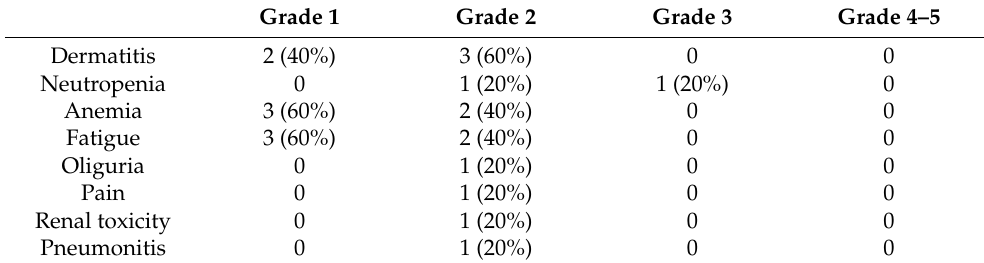
Table 2. Side effects for TTFields with pemetrexed and platinum-based chemotherapy regimen.